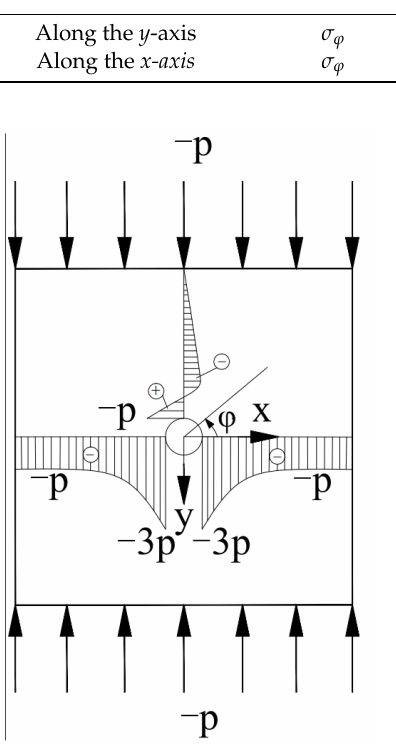
Table 6. Circumferential stress value along the x-axis and y-axis of the hole edge. Circumferential Stress Value/MPa